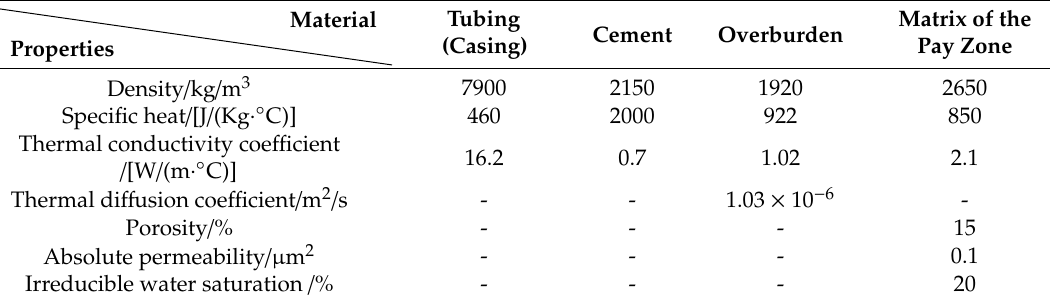
Table 3. Data used in model comparison.